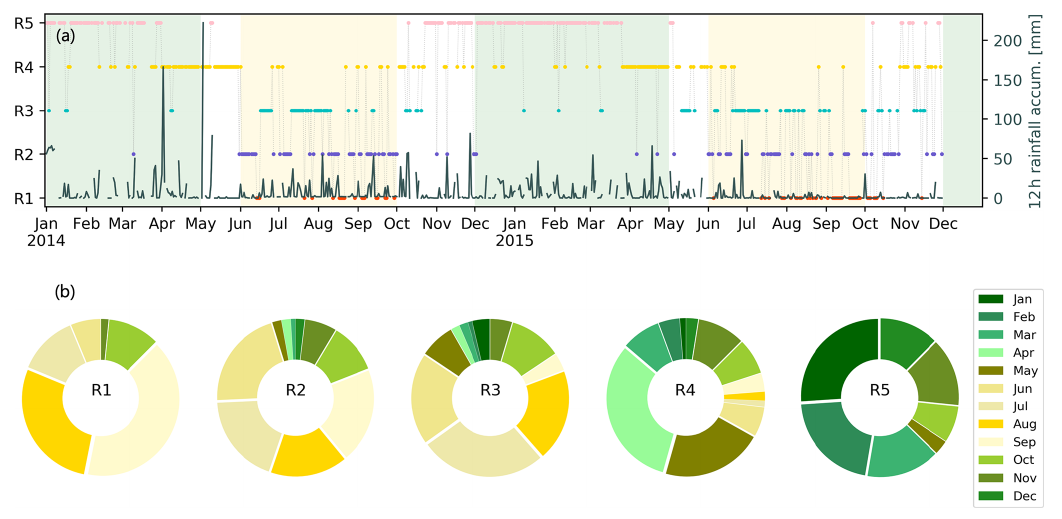
Figure 2. (a) Time series for Amazon regime cluster results (color coded as in Fig. 1) with corresponding 12h (12:00–00:00UTC) rainfall accumulation (from the MAO rain gauge). The green shading indicates the wet seasons, and the yellow shading indicates the dry seasons according to the calendar definition. (b) Relative breakdown for the frequency of each regime according to